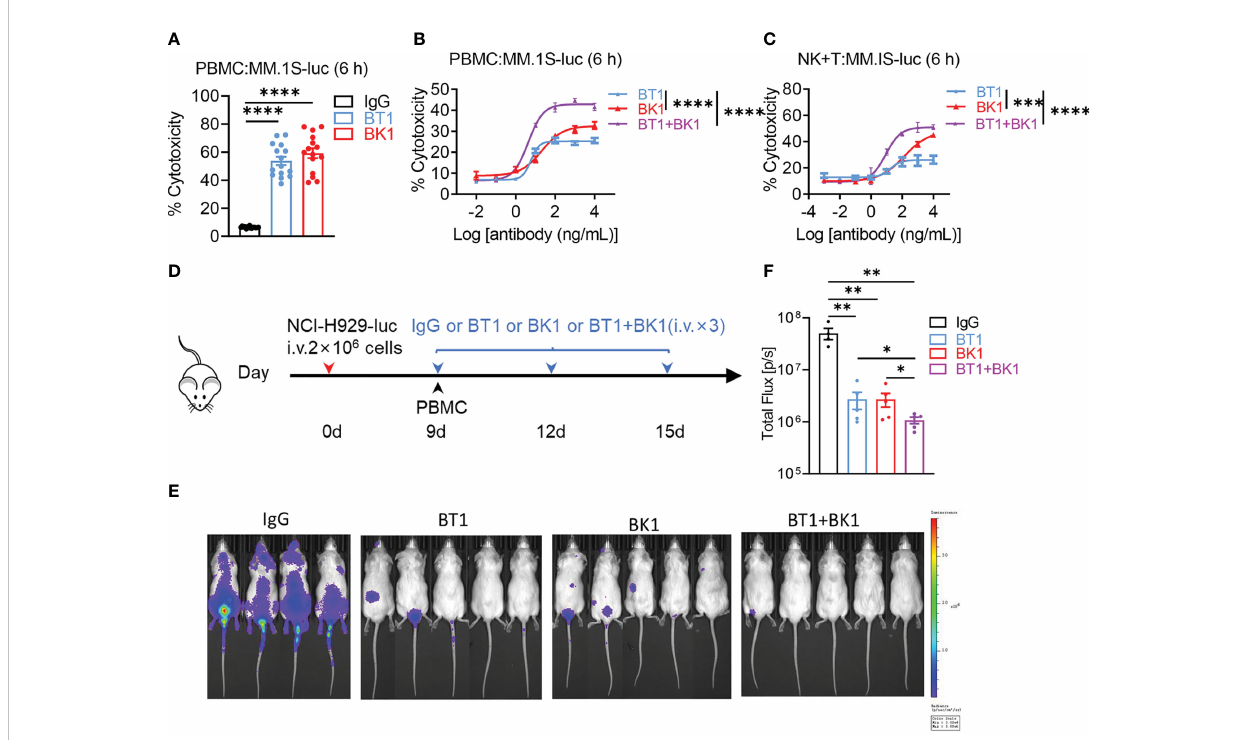
FIGURE 6 Combined treatment with BT1 and BK1 shows the strongest antitumor effects both in vitro and in vivo compared with either treatment alone. (A) Percentage of tumor cell lysis after coculturing MM.1S-luc cells with PBMCs (n=15) in the presence of BT1 or BK1 at an E:T ratio of 10:1 for 6 hours. (B) Percentage of tumor cell lysis after coculturing MM.1S-luc with PBMCs in the presence of BT1, BK1, or BT1 combined with BK1 (at the indicated concentrations) at an E:T ratio of 10:1 for 6 hours. (C) Percentage of tumor cell lysis after coculturing MM.1S-luc cells with a 1:1 mixture of puri fi ed NK cells and T cells in the presence of BT1, BK1, or BT1 combined with BK1 (at the indicated concentrations) at an E:T ratio of 2:1 for 6 hours. (D) Experimental protocol for the tumor model used in (E, F) : NSG mice (n = 4 or 5/group) were injected intravenously (i.v.) with NCI-H929- luc tumor cells (2 × 10 6 ) on day 0 followed by intravenous injection of PBMCs (5 × 10 6 ) on day 9. Tumor-bearing mice were injected intravenously (i.v.) with IgG, BT1, BK1 or BT1+BK1 (50 m g/mouse) every 3 days for a total of 3 doses beginning on day 9. (E) In vivo bioluminescence imaging of mice 15 days after tumor challenge described in (D) . (F) Quanti fi cation of luminescence in IgG-treated, BT1-treated, BK1-treated or combined- treated mice on day 15. Each symbol (E, F) represents an individual mouse. (A-F) Data are representative of at least three independent experiments. Data were analyzed by 2-way analysis of variance or Student ’ s t test. *P < 0.05; **P < 0.01, ***P < 0.001, ****P <